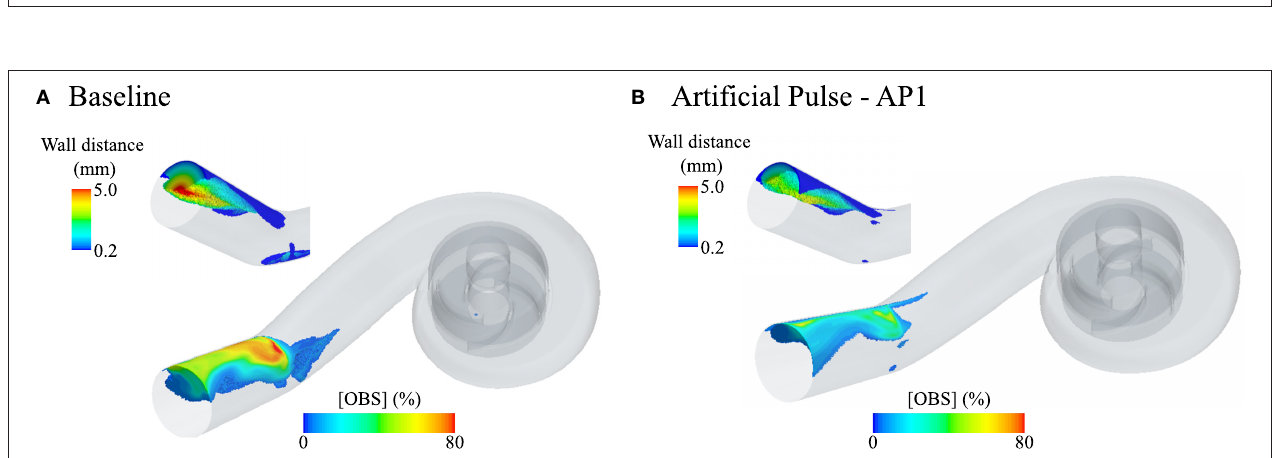
FIGURE 9 | Fluid volumes in the HeartMate 3 (HM3) pump core and outlet cannula with residual OBS concentrations over 5% after flushing the pump with two times its blood volume ( V f = 2.0) without AP [ (A) , baseline conditions] and with AP [ (B) , AP1 scenario]. At V f = 2.0, the average residual OBS concentration is 1.7 and 1.5% in the core pump for the Baseline and AP1 scenario, respectively, and is 4.5% at baseline and 3.5% for AP1 in the outlet cannula. For ease of visualization, only fluid volumes with [OBS] ≥ 5% and more than 200 µ m away from the pump surfaces are shown. Apart from a small region under the rotor at baseline, no 5% OBS isovolume are identified in the pump core at that instance. The insets show the 5% OBS isovolumes in the outflow cannula color coded by wall distance to highlight the penetration depth of that region under baseline conditions and the effect of the AP on its clearance.